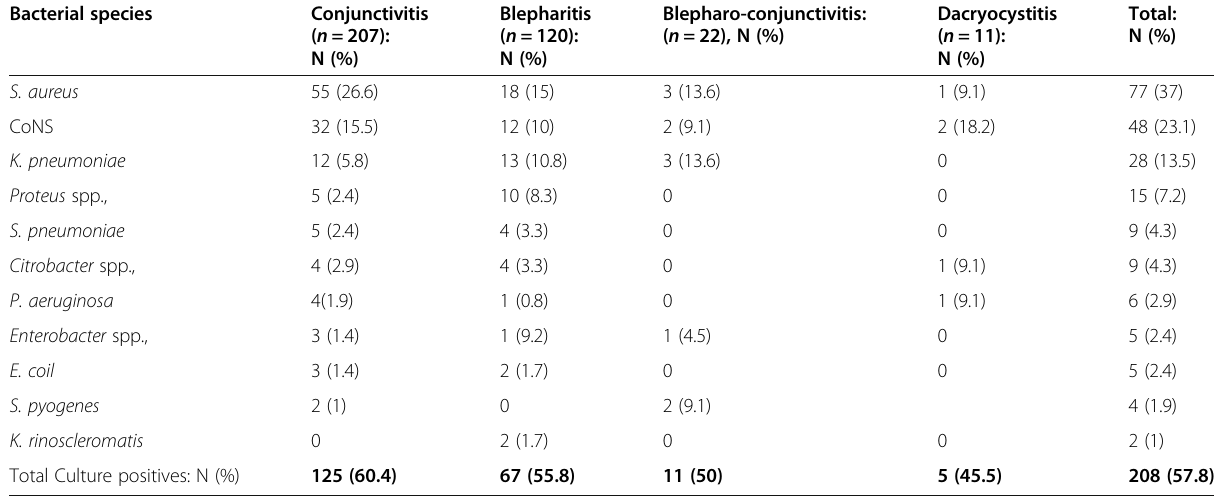
Key: CoNS Coagulase negative respectively. From cases of dacryocystitis, Coagulase negative Staphylococcus (18.2%) was the commonest or- ganism followed by S. aureus (9.1%), Citrobacter spp., (9.1%) and P. aeruginosa (9.1%) (Table 2). Multivariable analysis of external ocular infections (AOR = 3.53, 95% CI = 2.175 – 5.731), eye allergy (AOR =